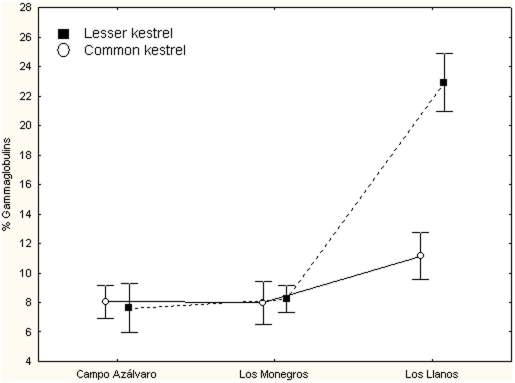
Between-area differences in kestrel gammaglobulin levels.Differences in gammaglobulin levels (percentage of total proteins) between the three study areas for both Eurasian and Lesser kestrels. Interaction between species and study area is statistically significant.